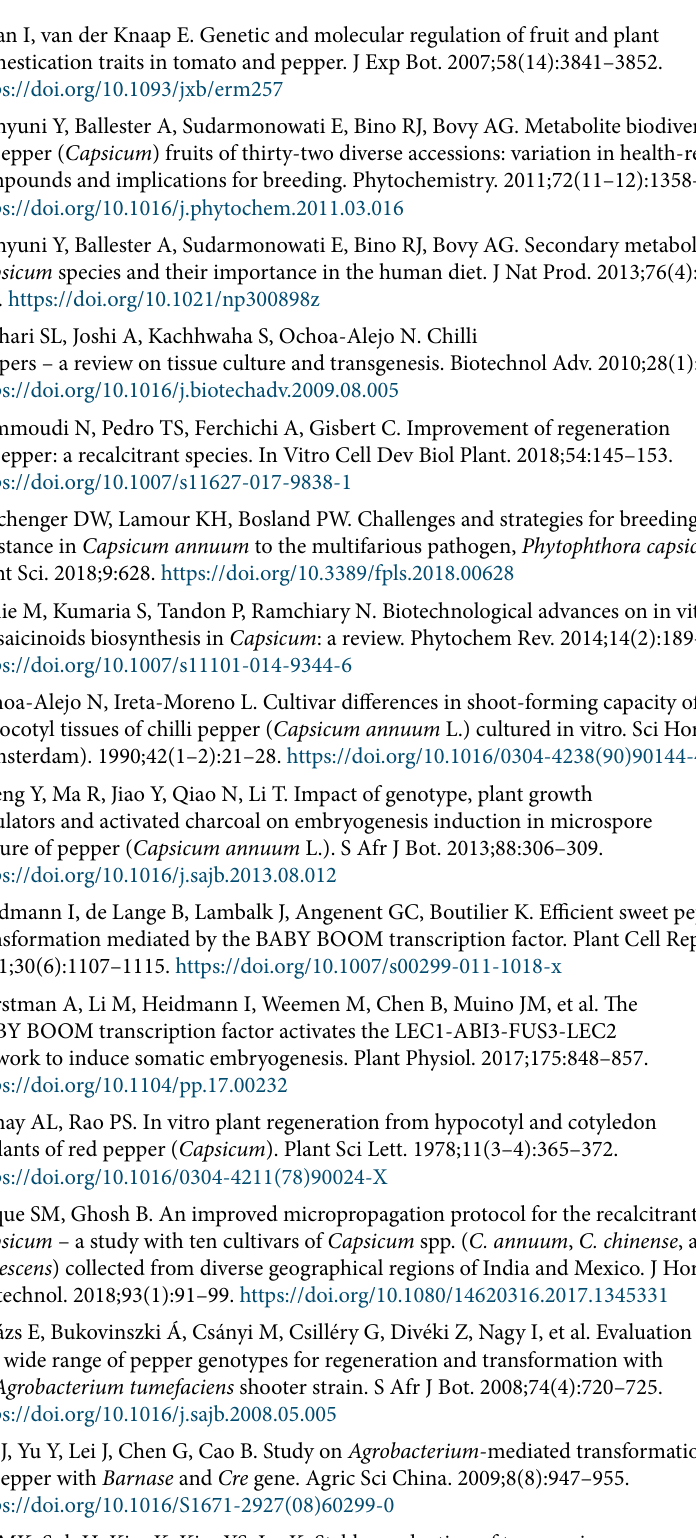
Fig. S2 Total fluorescence under UV light illumination and immunoblot with anti-GFP anti- bodies of protein extracts from C. annuum L. calli. Fig. S3 Silver-stained SDS-PAGE of soluble protein extracts for C. annuum L. calli. Fig. S4 Cell suspensions of C. annuum L. Tab. S1 Protein concentration and Mg 2+ -dependent pyrophosphatase activity in crude